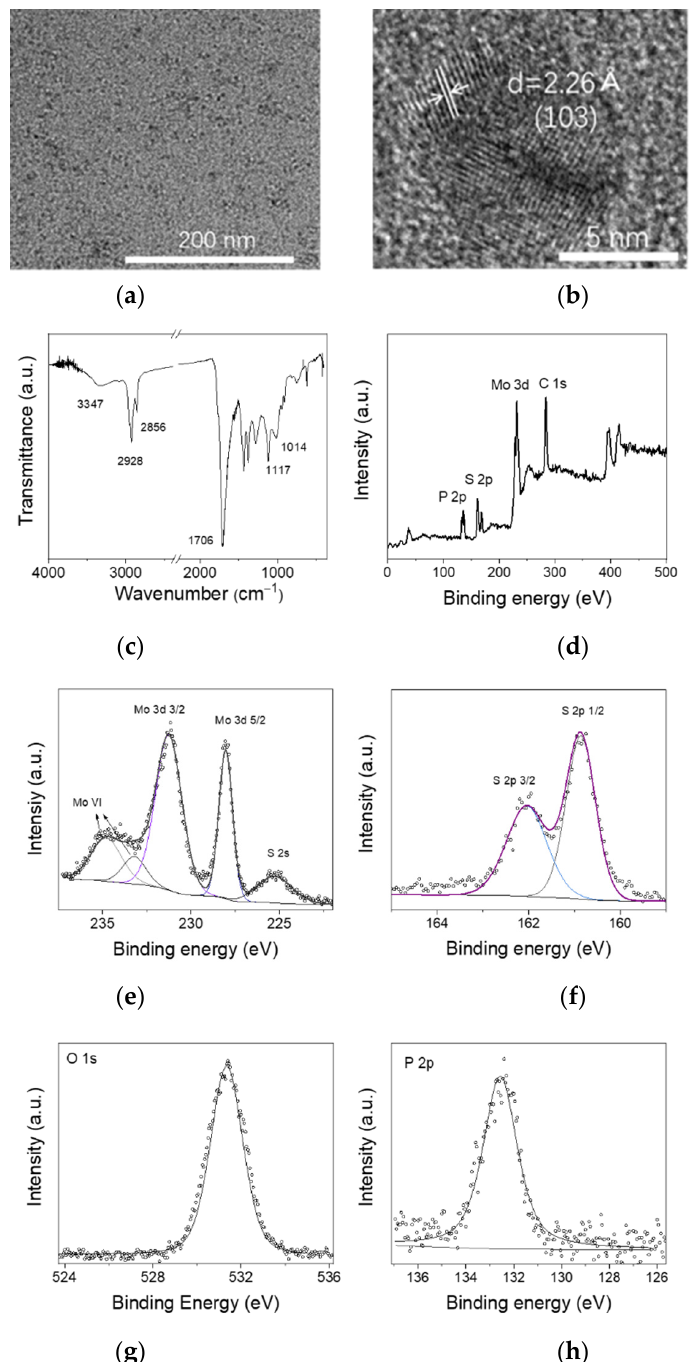
Figure 1. ( a ) TEM image, ( b ) high-resolution TEM images, ( c ) FTIR spectrum of the MoS 2 QDs. ( d ) XPS survey spectrum of the MoS 2 QDs. ( e ) High-resolution peak-fitting XPS spectrum of Mo 3 d . ( f ) High-resolution peak-fitting XPS spectrum of S 2 p . ( g ) High-resolution peak-fitting XPS spectrum of O 1 s . ( h ) High-resolution peak-fitting XPS spectrum of P 2 p